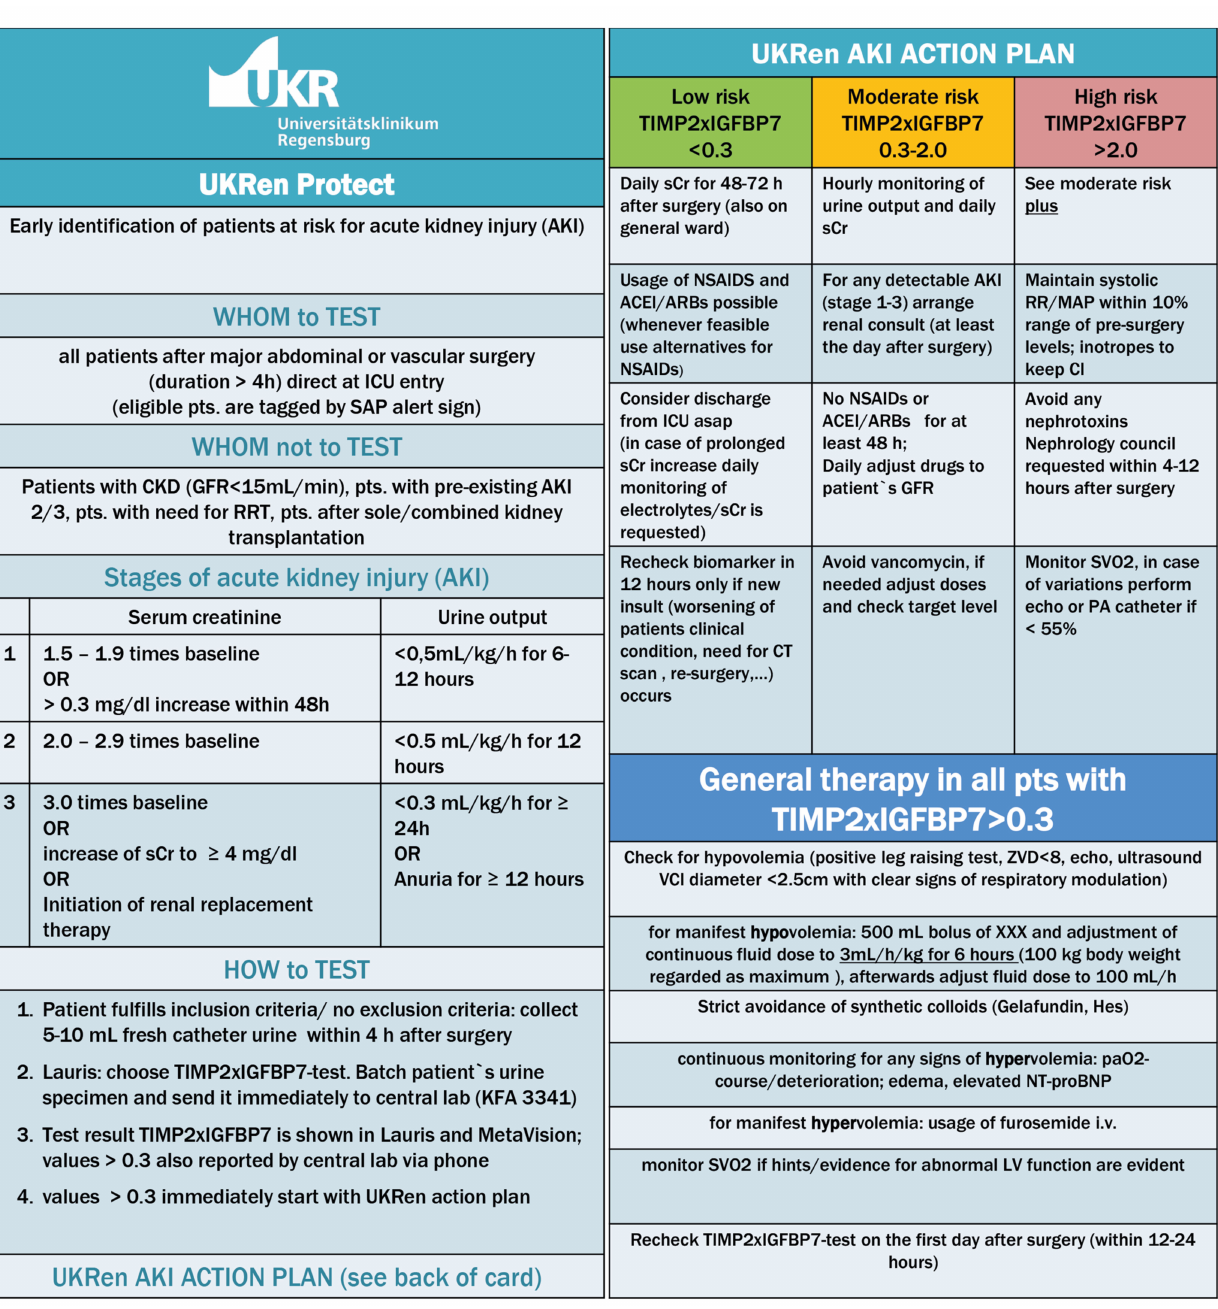
Figure 2. The renal intervention